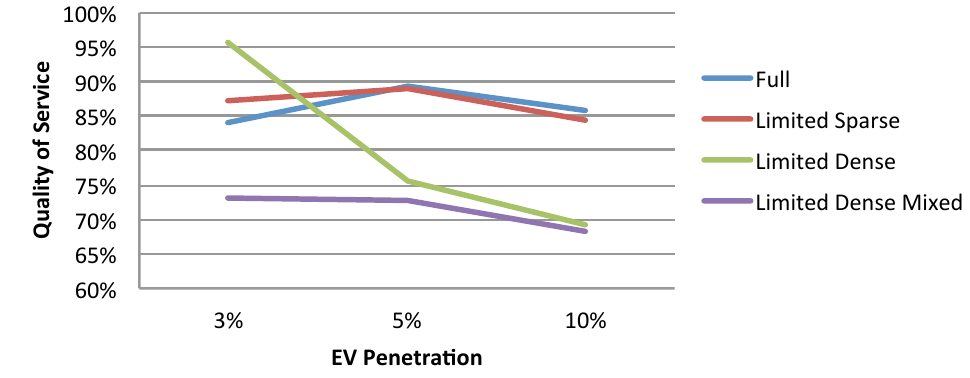
Figure 9. Quality of service